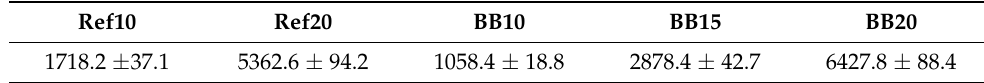
Table 4. Average dynamic viscosity values (mPa · s).